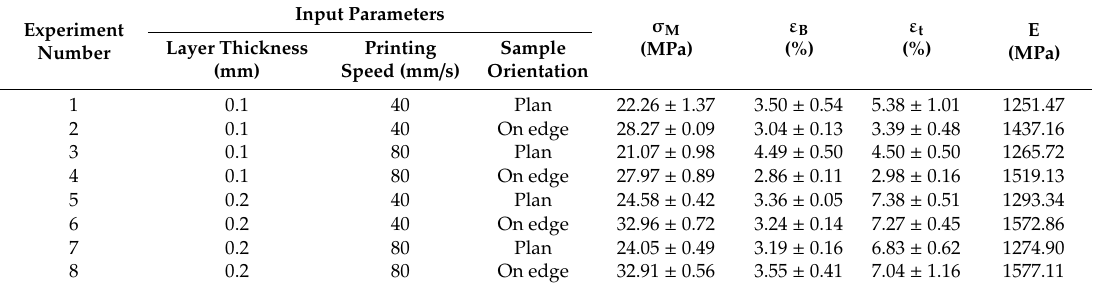
Table 1. Experimental results of tensile tests performed on the Extrudr BDP Flax samples. Experiment Number